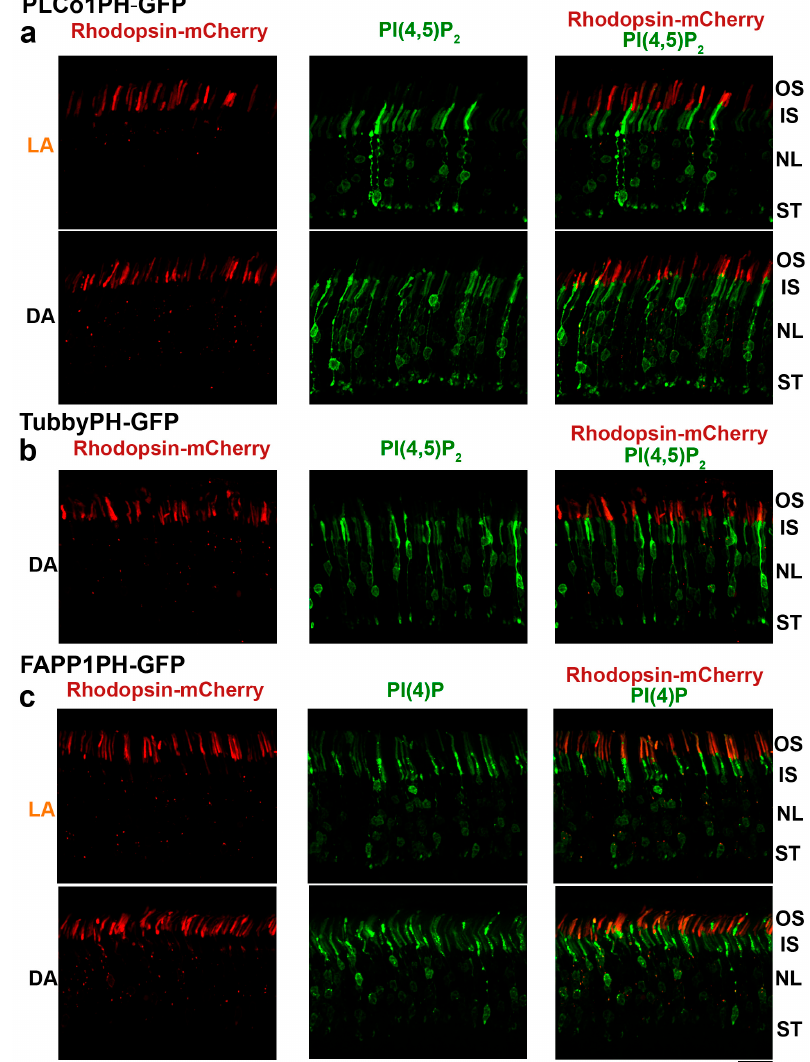
Figure 3. Distribution of PI(4)P and PI(4,5)P 2 phosphoinositide sensors in rod photoreceptors. Green Fluorescent Protein (GFP) fusion constructs of PI(4,5)P 2 -binding domains from PLC δ 1 ( a ) and Tubby ( b ) proteins and the PI(4)P-binding domain of FAPP1 ( c ) were electroporated at P0 into rod photoreceptors to investigate the localization of corresponding phosphoinositides. Their distribution patterns (green) were analyzed in retinal cross-sections of 6-week-old dark (DA)- or light (LA)- adapted mice. Rhodopsin fused with mCherry (red) was used as a rod outer segment marker. PI(4,5)P 2 sensors produce intense signals in the inner segments (IS), nuclear layer (NL) and synaptic terminals (ST), but are virtually excluded from outer segments (OS). The PI(4)P sensor shows signal in the outer segments, around nuclei, and in the inner segments. Occasional red puncta detected in the inner segments most likely represent mistargeted Rhodopsin-mCherry fusion protein. Scale bar: 20 µm.